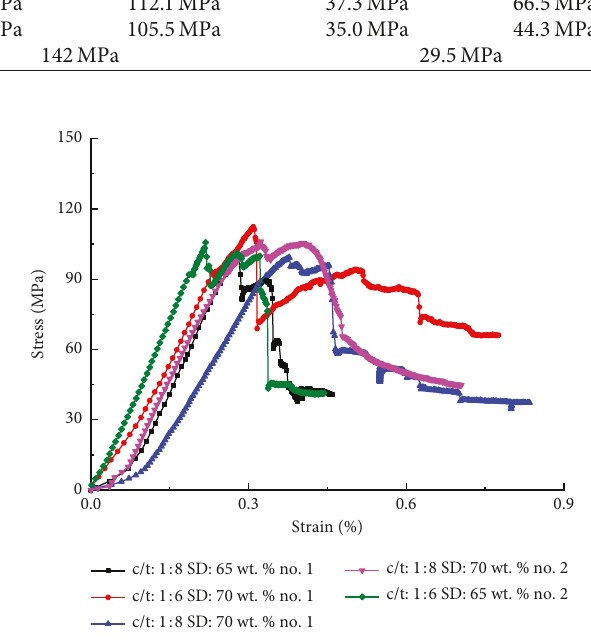
Figure 4: Stress-strain curves of different types of RCTMC samples.